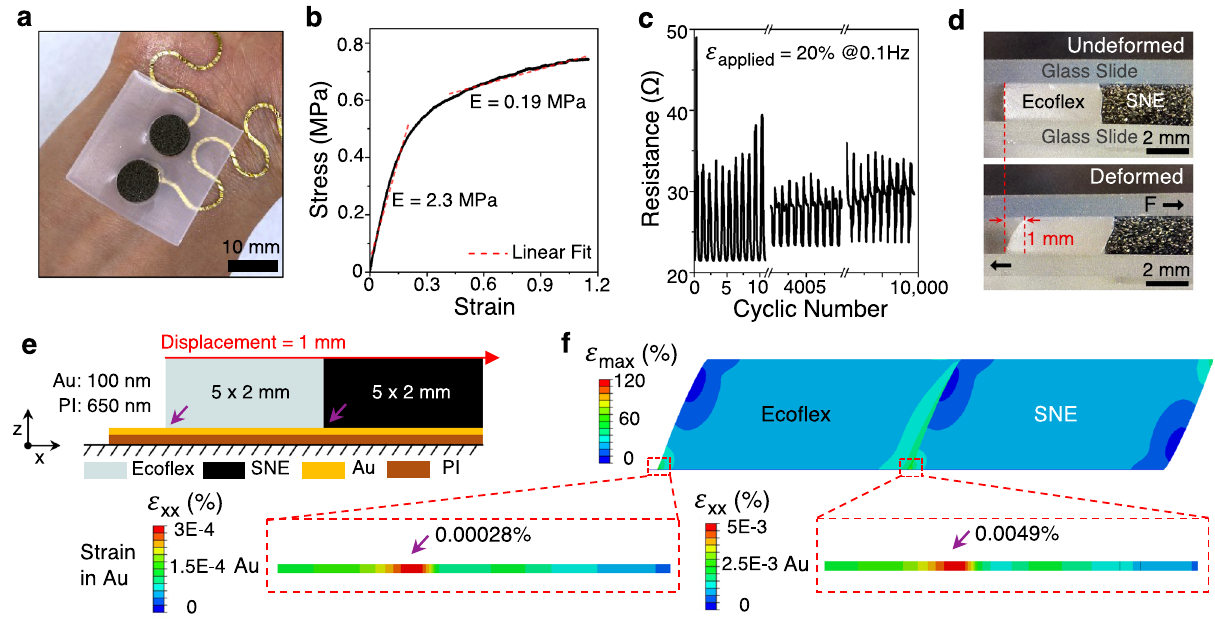
Fig. 3 | Strain isolation effect of the soft interlayer. a Photograph of a soft interlayercoveringtheAu/PIlaminatedonthehumanwrist. b Stress-straincurveof the commercialconductive silicone rubber(SNE-553). c Cycliccompressiontestof SNE-553diskunder20%ofcompressivestrainwith0.1Hztocon fi rmthestabilityof resistance. d Side-view of Eco fl ex and SNE-553 sandwiched by glass slides before and after a shear displacement of 1mm. e FEM schematic to validate the strain